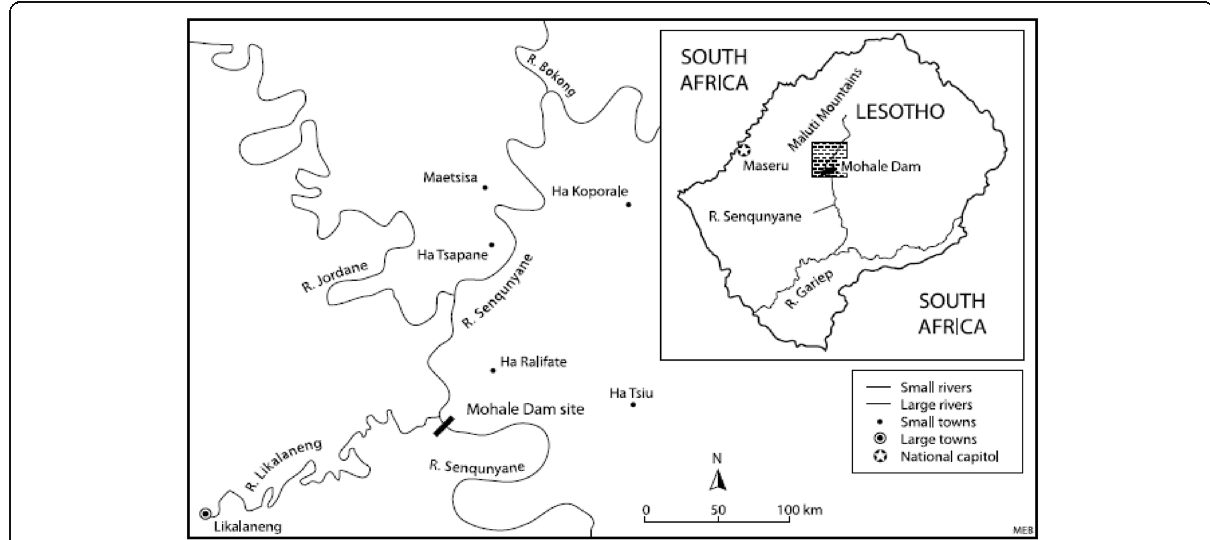
Fig. 1 Mohale Basin. Source: